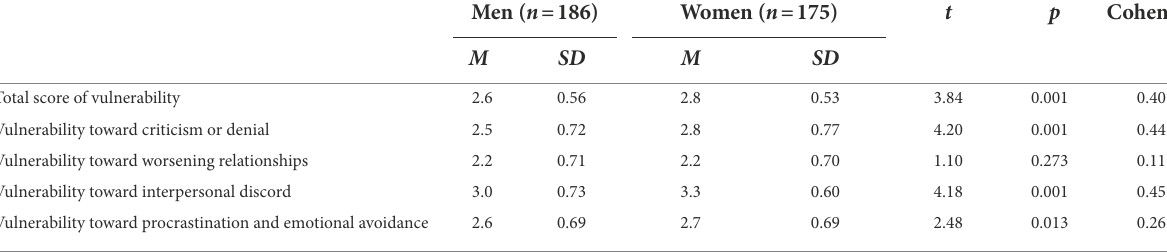
TABLE 2 Sex differences in total vulnerability scores and subscale scores ( t